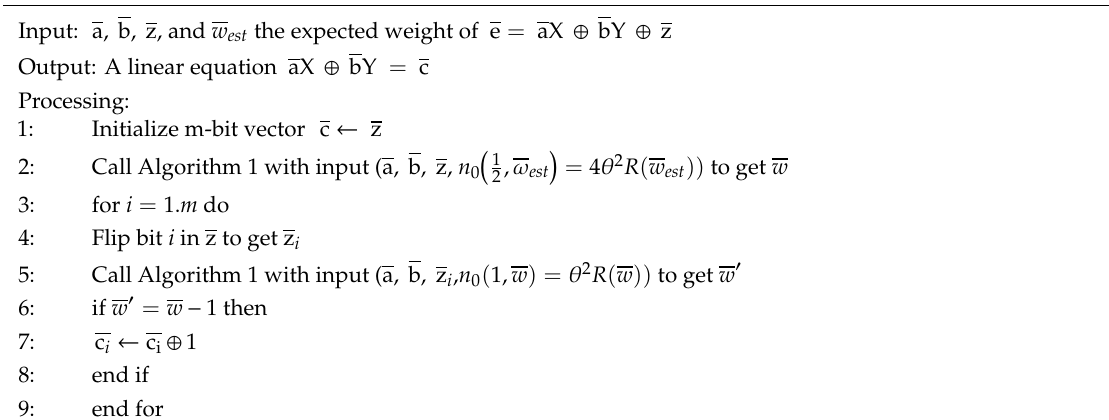
OOV Algorithm 2 [13]: Getting linear equations for secret keys X , Y